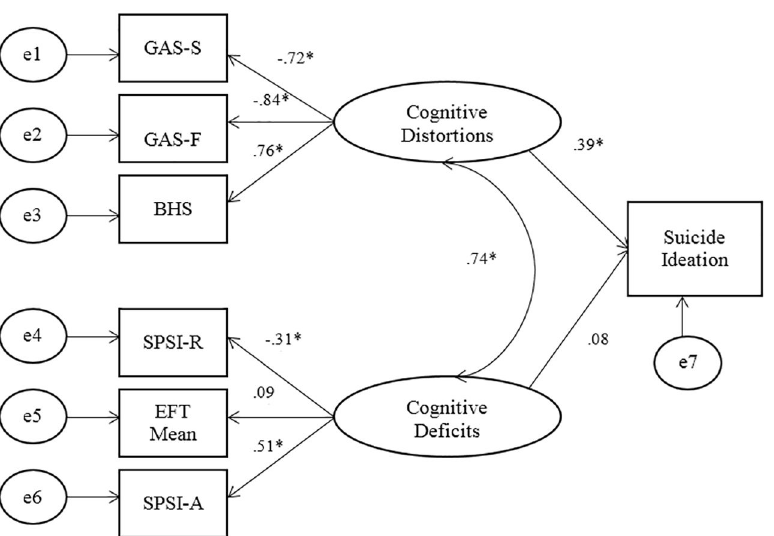
Figure 1. SEM statistics for the Modified Cognitive Distortions and Cognitive Deficits Model of Suicidal Thinking. Note. Suicide Ideation = BSS Total Score; GAS-S = General Attitudes Scale-Self; GAS-F = General Attitudes Scale-Future; BHS = Beck Hopelessness Scale; SPSI-R = Social Problem-Solving Inventory – Rational problem-solving; EFT-mean = Embedded Figures Test-mean time; SPSI-A = Social Problem-solving Inventory-Avoidant problem-solving. * p <